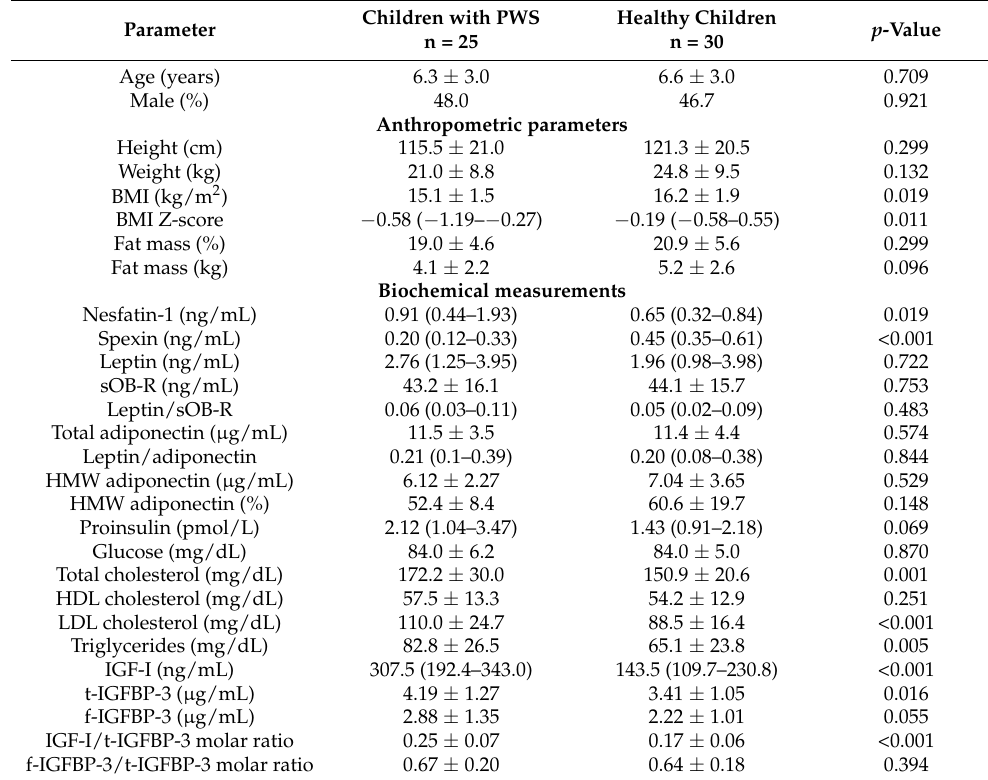
Table 1. Anthropometric and biochemical characteristics of children with PWS and healthy children.